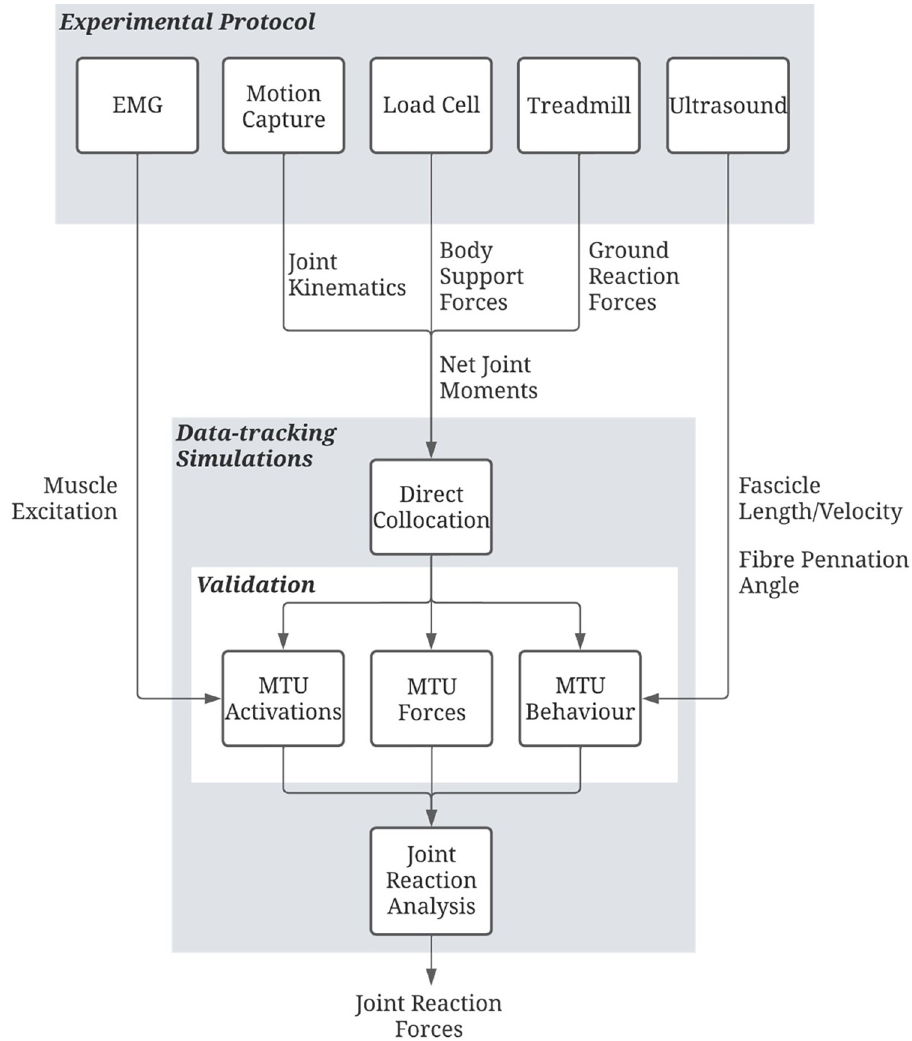
Fig 3. A schematic of the data workflow to obtain the main outcome measure, joint reaction forces. Experimental data are fed into the direct collocation optimal control framework to perform data-tracking simulations. Experimental EMG and ultrasound data are compared to simulated muscle-tendon unit (MTU) activations and behaviour, respectively, to validate the simulated MTU outcomes. The MTU outcomes are then used to inform a joint reaction analysis to calculate the joint reaction forces as a function of simulated kinematics, external loads (ground reaction and support forces), and MTU forces. EMG = electromyography. Muscle-tendon unit modelling . Three-element Hill-type muscle model formulations will be used in this framework [61, 67, 68]. Briefly, the MTU complex consists of a contractile compo- nent, a passive elastic component parallel to the contractile component, and a series passive elas- tic component. Active (force-length and force-velocity) and passive (parallel and series) force generation are modelled via the dimensionless equations presented by De Groote et al ., [69]. The parameters maximum isometric force, optimum fibre length, pennation angle at optimum fibre length, maximum shortening velocity, and tendon slack length are used to describe the dimensionless formulations. The MTU parameters will be scaled based on the participant’s anthropometrics (i.e., segment length, width and depth). Total MTU lengths will be adjusted during scaling such that the ratio of optimal fibre length to tendon slack length is maintained.